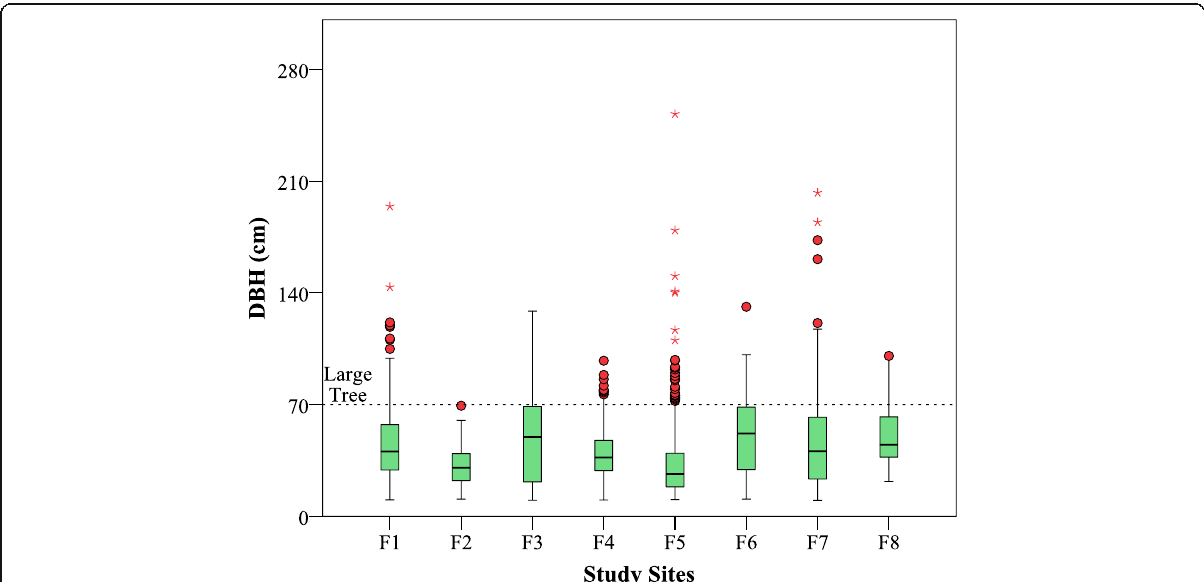
Fig. 3 Box-whisker plot representing median DBH distribution of the study sites. The Horizontal line in the box represents median value, the box represents interquartile (IQ) range (25th – 75th percentile), the whiskers represent the highest and lowest values ( ≤ 1.5 times IQ range), outliers are up to 3 times IQ range, and, extreme outliers beyond this range are represented with an asterisk